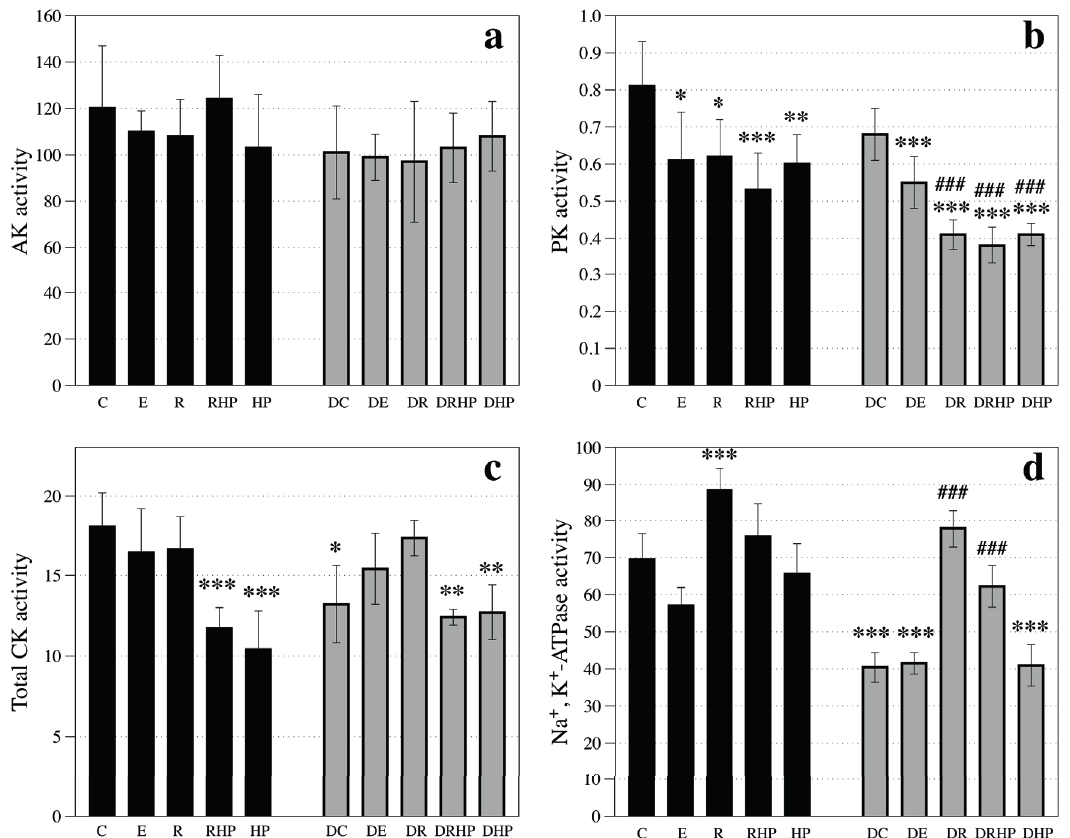
Figure 3 - Eff ects of free and resveratrol-hydroxypropyl-β-cyclodextrin administration on enzyme activities in spleen of non-diabetic and diabetic rats. ( a ) AK activity ( b ) PK activity ( c ) CK activity ( d ) Na + , K + -ATPase activity. data are mean ± standard deviation (Sd) for 5-7 animals in each group. C (Control), e (ethanol), R (Resveratrol), RHP (Resveratrol- hydroxypropyl-β-cyclodextrin), HP (Hydroxypropyl-β-cyclodextrin), DC (Diabetic control), DE (Diabetic ethanol), DR (Diabetic resveratrol), DRHP (Diabetic resveratrol-hydroxypropyl-β-cyclodextrin) and DHP (Diabetic Hydroxypropyl- β-cyclodextrin). * p < 0.05; ** p < 0.01; *** p < 0.001 compared to non-diabetic control and ### p < 0.001 when compared to diabetic control (one-way ANOVA followed by Tukey